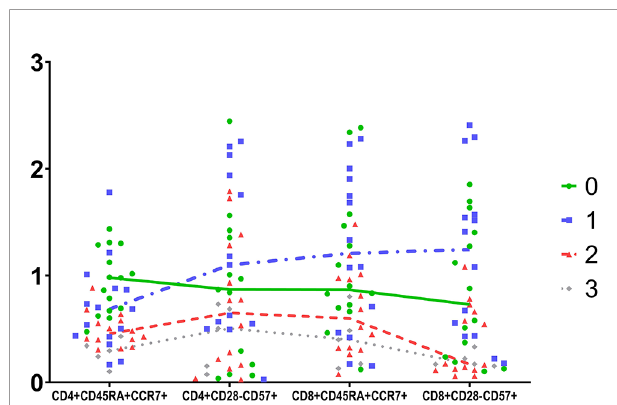
FIGURE 4 | Schematic comparison of four T cells subpopulations in the four groups determined by UMAP. Data were scaled to unit.